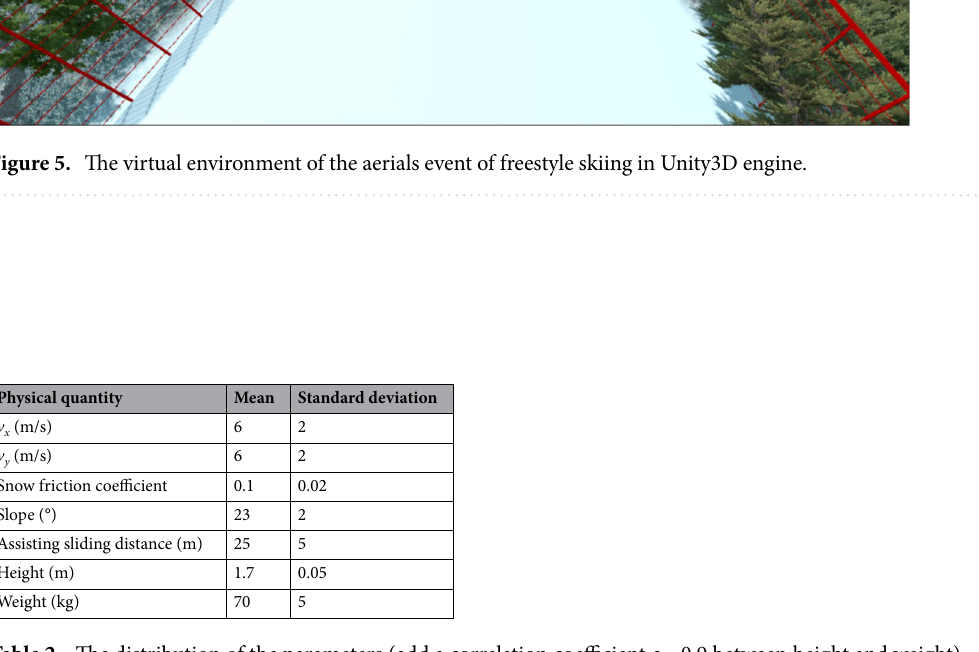
Table 2. The distribution of the parameters (add a correlation coefficient ρ = 0.9 between height and